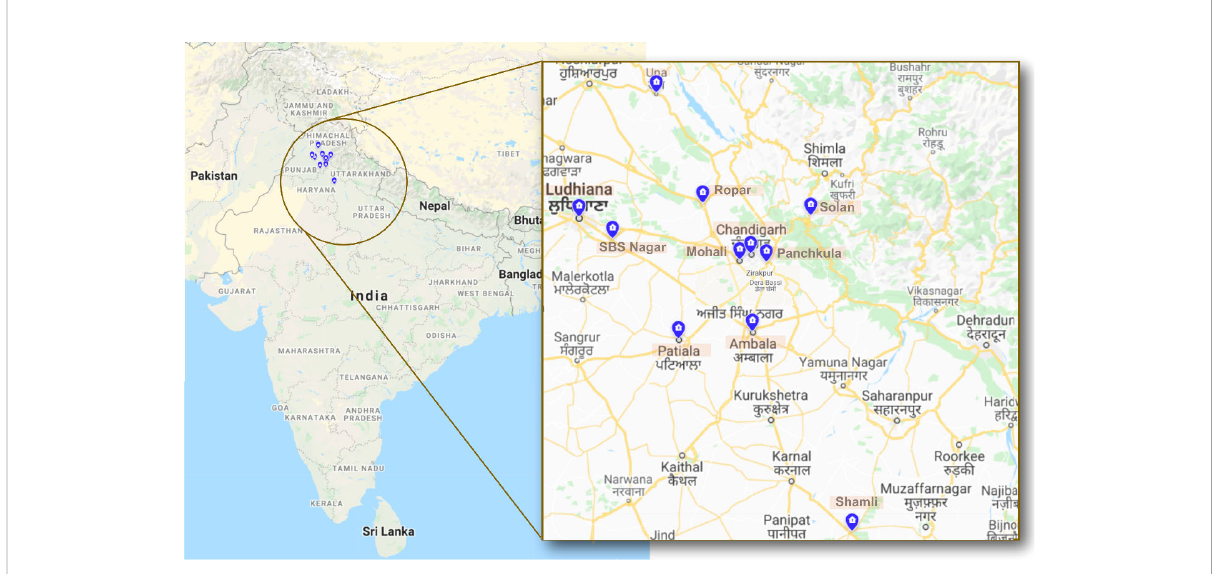
FIGURE 1 The map depicting the districts where environmental sampling was performed. The states from where sampling was performed are indicated in the circle, i.e., Punjab, Haryana, Uttar Pradesh, Himachal Pradesh, and Chandigarh. The blue highlights indicate the various districts within these states from where the samples were collected.